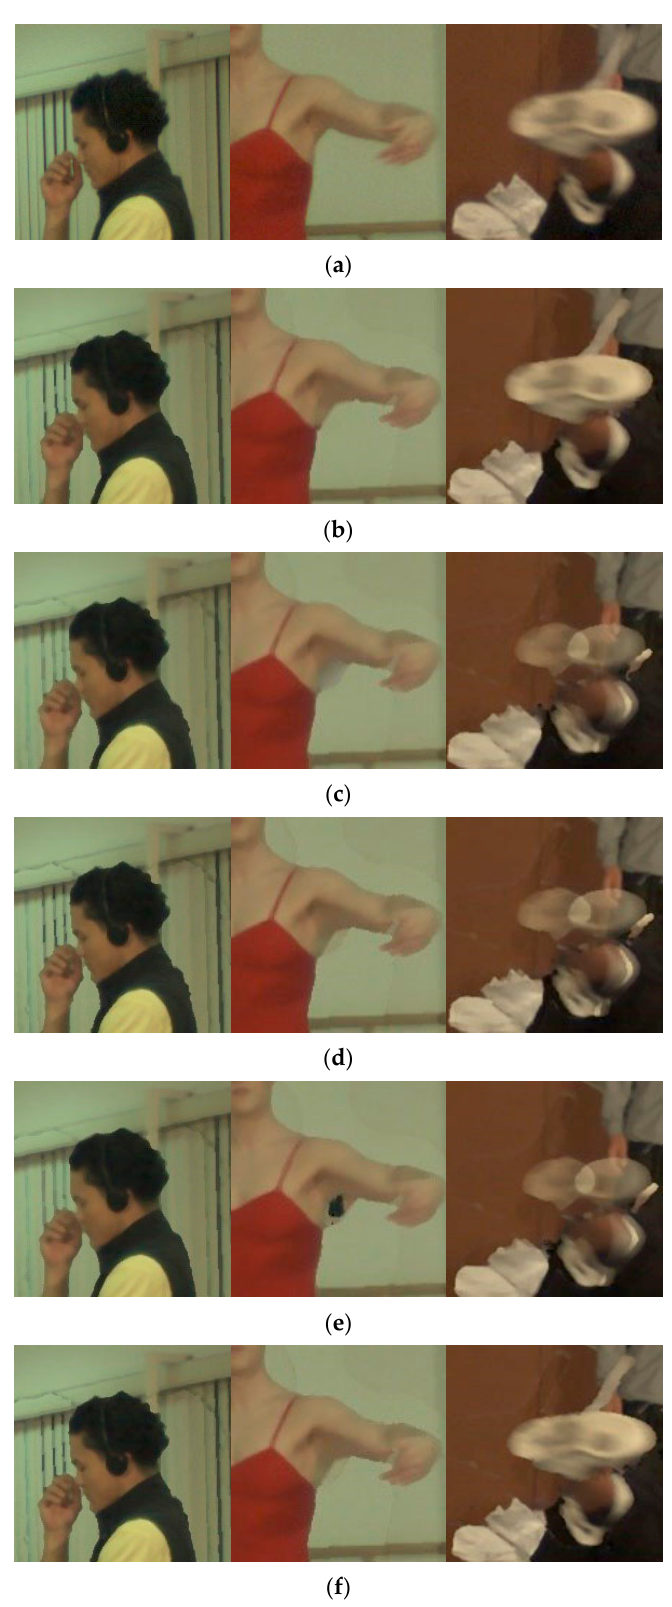
Figure 20. Enlarged images corresponding to the 1st and 73rd frames of Ballet and the 36th frame of Breakdancers. ( a )Ground truth of Camera 4 of ( b ) our proposed method, ( c ) Cheng et al.’s method [21], ( d ) Cho et al.’s method [19], ( e ) Luo and Zhu’s method [26], and ( f ) Oliveira et al.’s method [27].